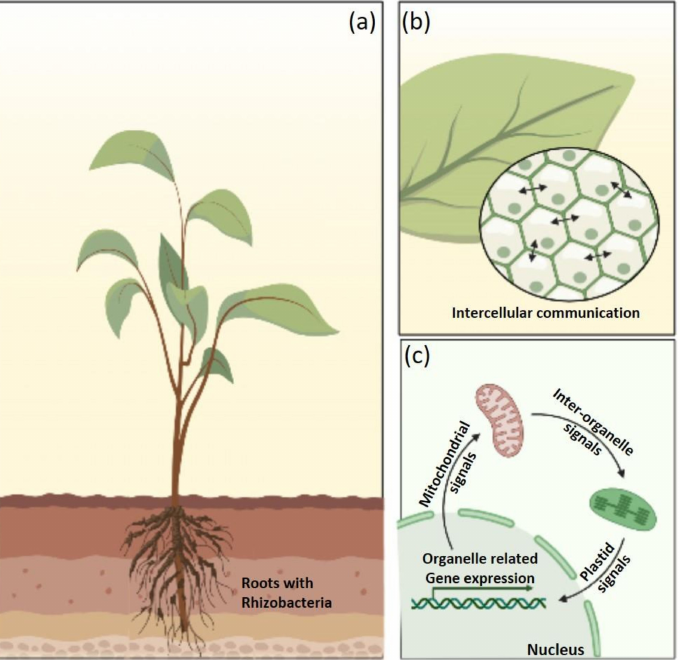
Figure 2. Plant-microbiome interactions: ( a ) PGPR association with roots of the plant, ( b ) Microbial interactions enhancing cellular signaling, and ( c ) Signaling pathway along different modules affecting gene expression and, as such, overall performance of the